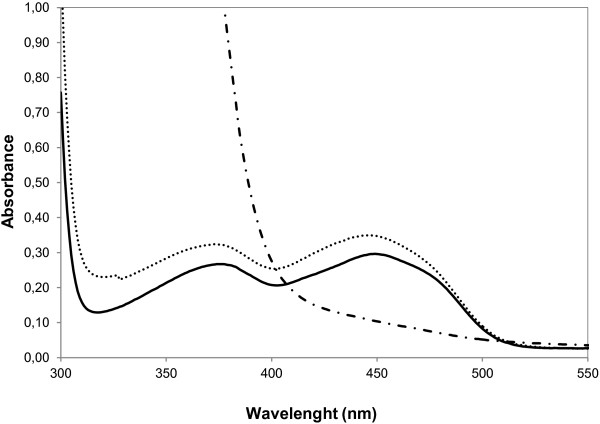
Spectral characterization of BVMOAf1. Visible spectra of native BVMOAf1 (solid line) and BVMOAf1 after unfolding by 1% SDS and incubation at 80°C (dotted line). Spectral changes observed upon reduction of BVMOAf1 by excess of NADPH (dashed line).